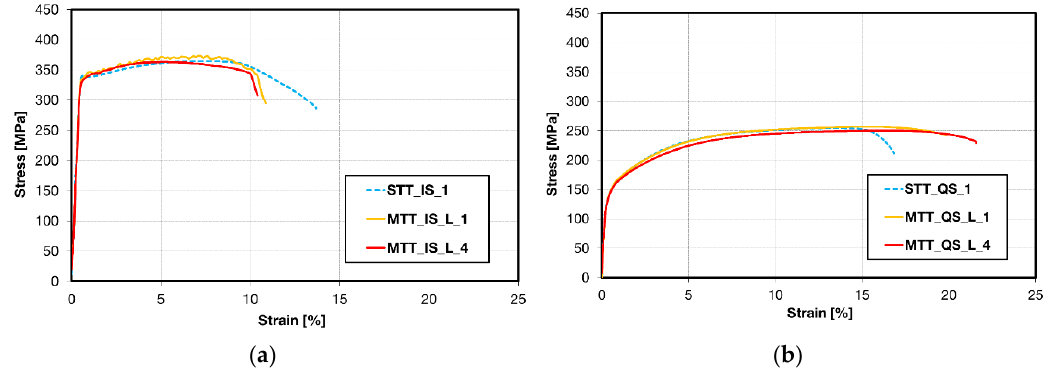
Figure 16. Engineering stress – strain curves obtained for ( a ) IS state and ( b ) QS state.